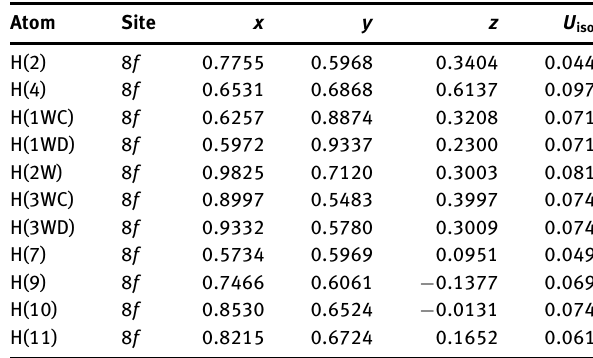
Table 2: Fractional atomic coordinates and isotropic or equivalent isotropic displacement parameters (Å 2